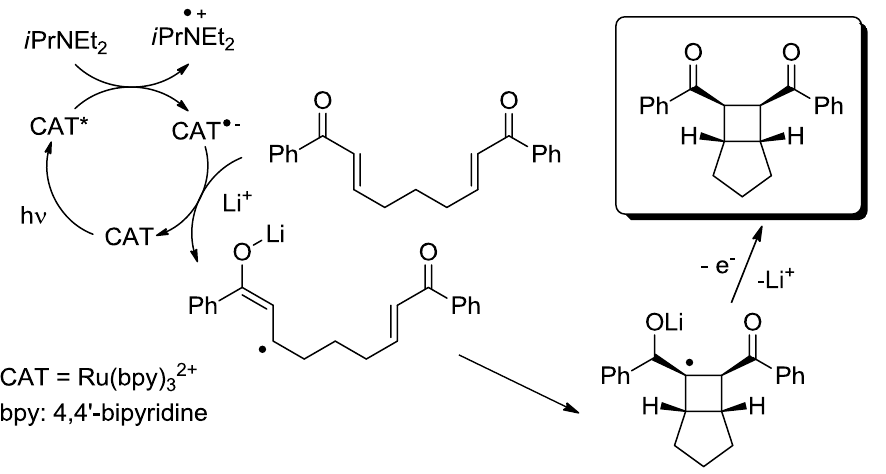
Scheme 5. Photocatalyzed cyclobutane ring formation exploiting a tertiary amine as a sacrificial electron donor